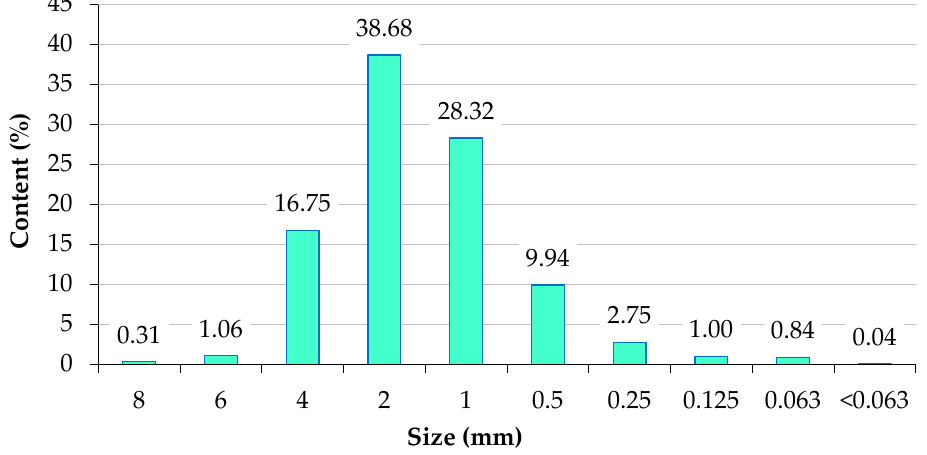
Figure 2. Particle size distribution of sage waste biomass.